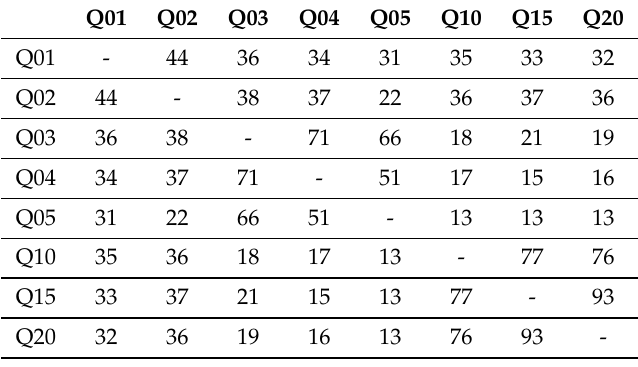
Table 14. Test results for similar Word documents with sdhash.